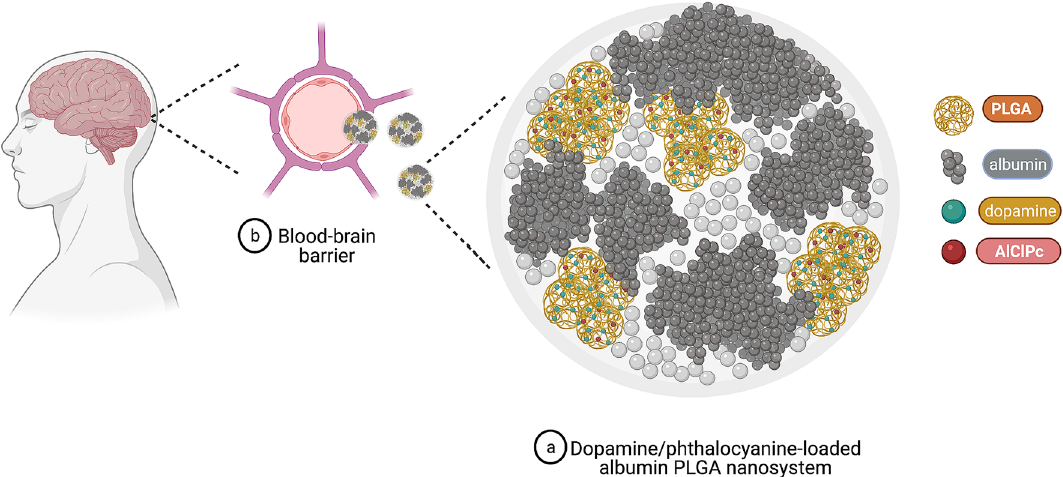
Figure 1. Schematic representation of our dopamine/phthalocyanine-loaded nanosystem’s structural assembly ( a ) and its interaction with the blood–brain barrier ( b ) to ultimately enter the brain parenchyma and release the drug/compound of interest. AlClPc aluminum chloride phthalocyanine, PLGA poly (lactic- co -glycolic acid). Created with Biorender.com.